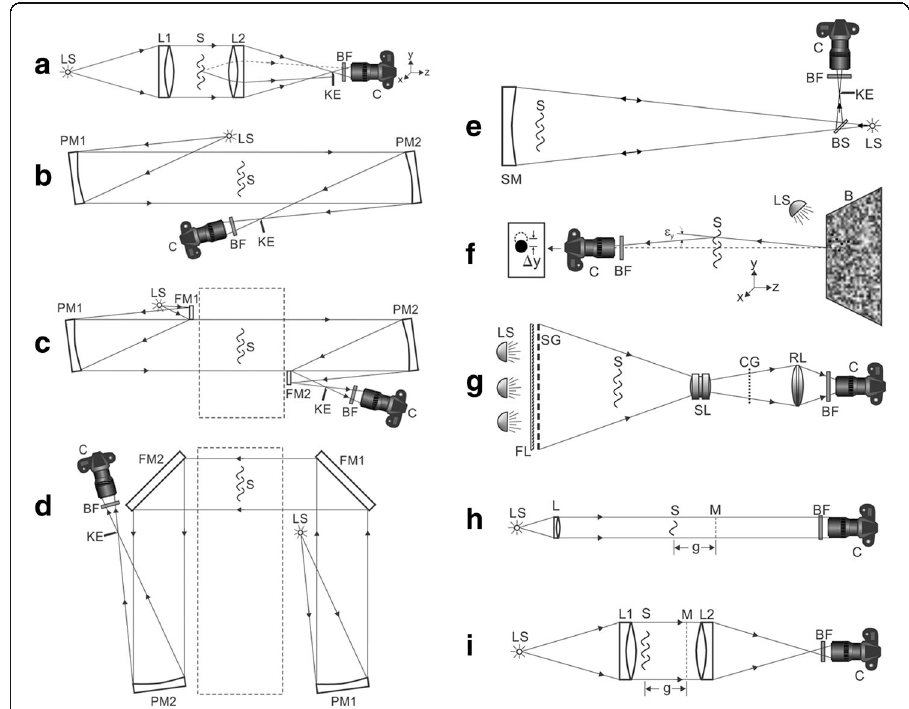
Fig. 1 Diagrams of different schlieren instruments: Toepler ’ s lens-type system ( a ), simple “ z-type ” system ( b ), folded z-type systems with both non-parallel schlieren beams folded ( c ) and with the parallel beam folded twice ( d ), single-mirror, double-pass schlieren arrangement ( e ), Background-Oriented Schlieren (BOS) ( f ), focusing (lens-and-grid) schlieren system ( g ), direct shadowgraph system ( h ) and “ focused shadowgraph ” system ( i ). The individual components of these setups are described in detail in the text. List of the used abbreviations: B – background; BF - bandpass filter; BS – beamsplitter; C- camera; CG – cutoff grid; FL – Fresnel lens; FM1 – folding mirror 1; FM2 – folding mirror 2; g – defocusing distance; KE – knife-edge; L – lens; LS – light source; L1 -schlieren field lens 1; L2 - schlieren field lens 2; M – plane of camera focus; PM1 – parabolic mirror 1; PM2 – parabolic mirror 2; RL – relay lens; S – schlieren object (plasma); SG – source grid; SL – schlieren lens; SM – spherical mirror;x, y, z – Cartesian coordinates; Δ y – ray displacement in y-direction; ε y – refraction angle in